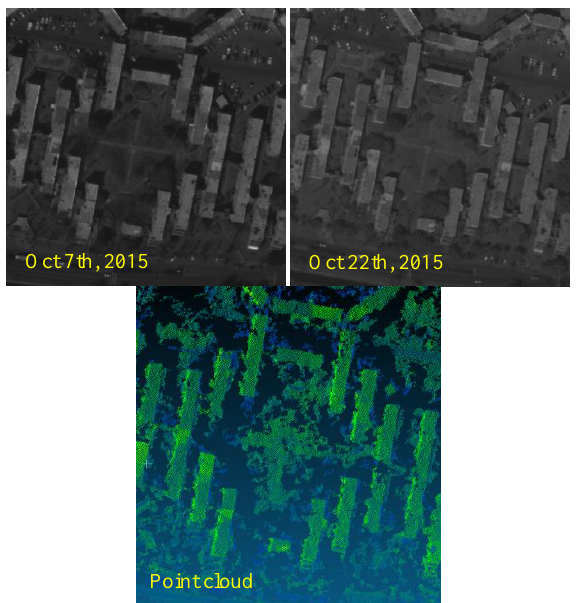
Figure 2. Images and point cloud from different season but